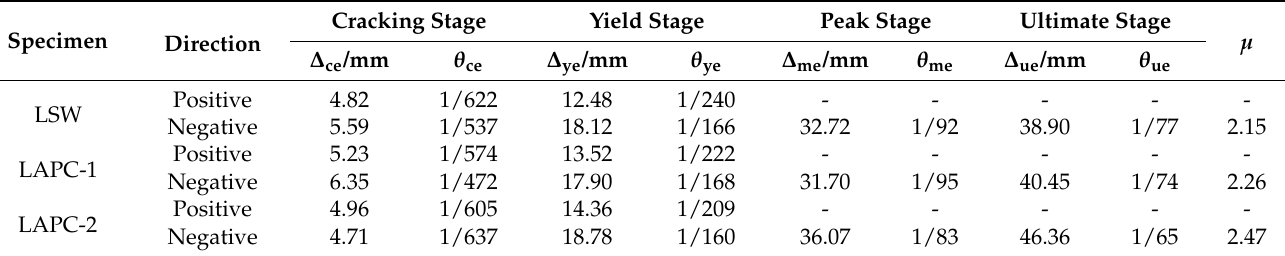
Table 3. Ductility coefficient of